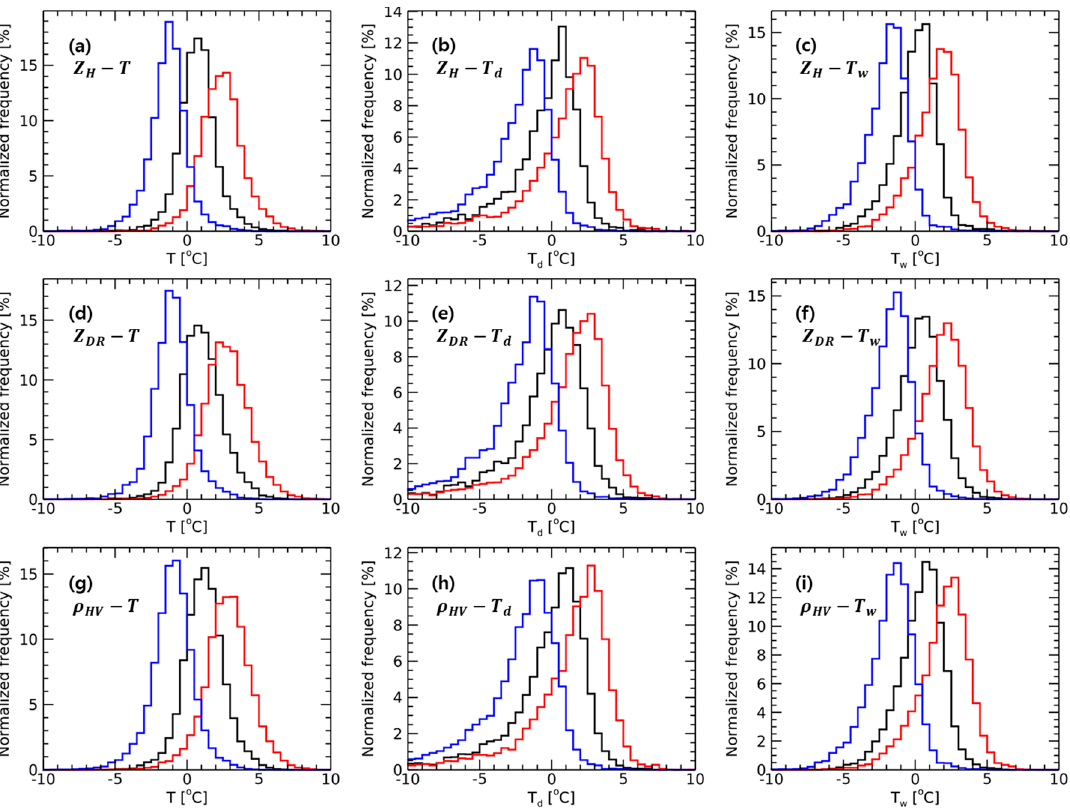
Figure 11. Normalized frequency distribution of ( a , d , g ) T, ( b , e , h ) T d , and ( c , f , i ) T w at top (blue), peak (black), and bottom (red) of bright band from QVPs of ( a – c ) Z H , ( d – f ) Z DR , and ( g – i ) ρ HV . Table 4. Mean and standard deviation (STD) of temperature (T), dew point temperature (T d ), and wet-bulb temperature (T w ) at the top, peak, and bottom of the BB. Value.